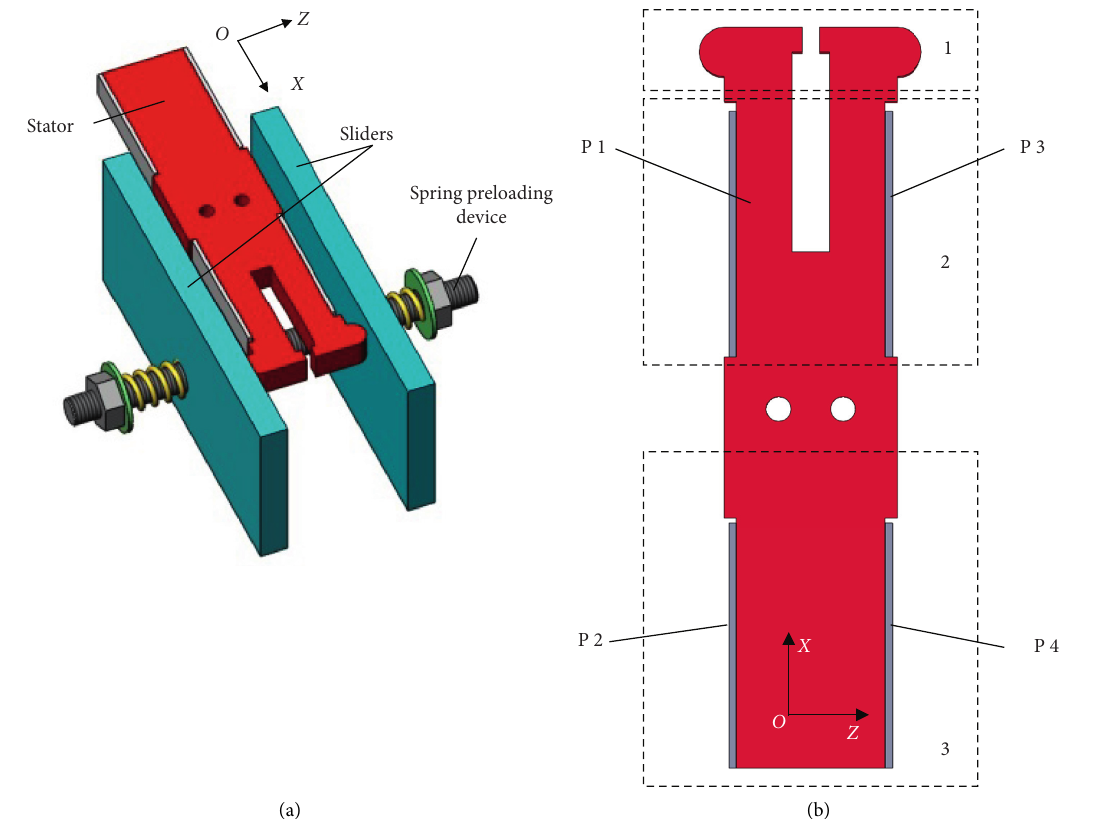
Figure 1: Structure diagram of LUSM. (a) 3D structure of LUSM. (b) Stator of